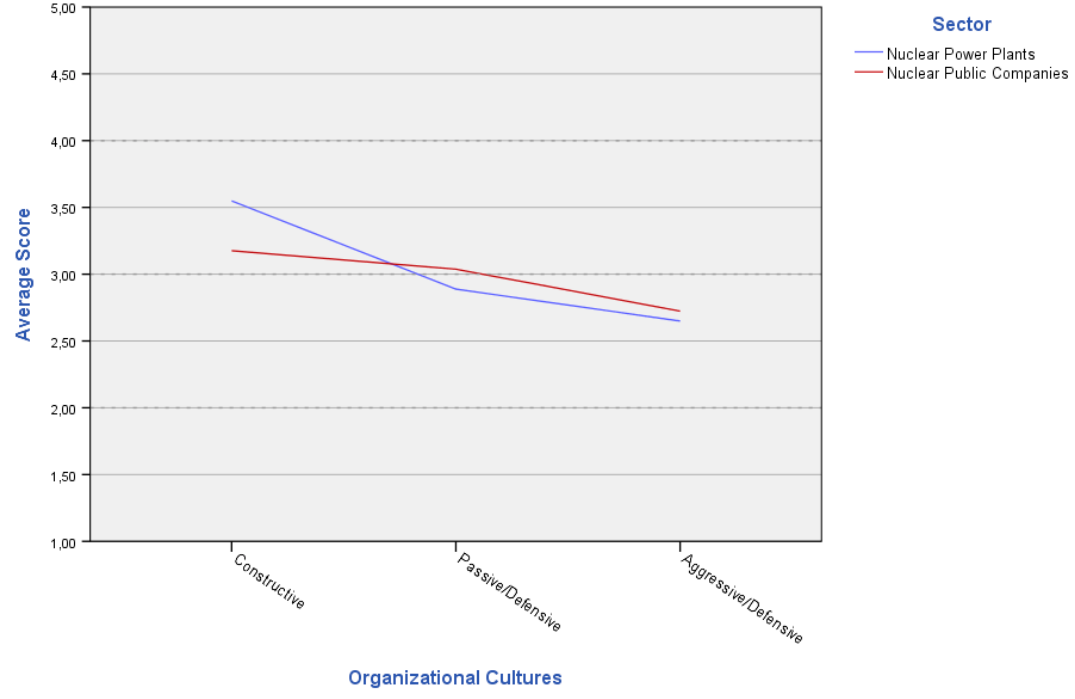
Figure 4. OCI organizational cultures averages by nuclear sector.